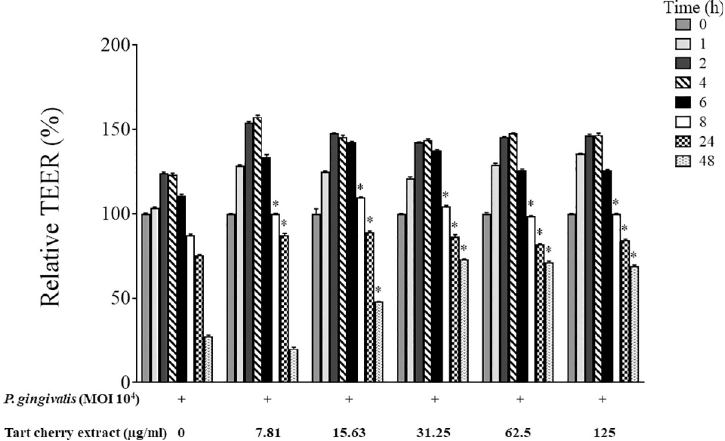
Fig 4. Effect of the tart cherry extract on the disruption of epithelial barrier integrity by P . gingivalis (MOI of 10 4 ) assessed by monitoring TEER over a period of 48 h. A 100% value was attributed to the TEER value at time 0. Results are expressed as the means ± SD of triplicate assays. � , Significantly different ( p < 0.01) from the control (no tart cherry extract).